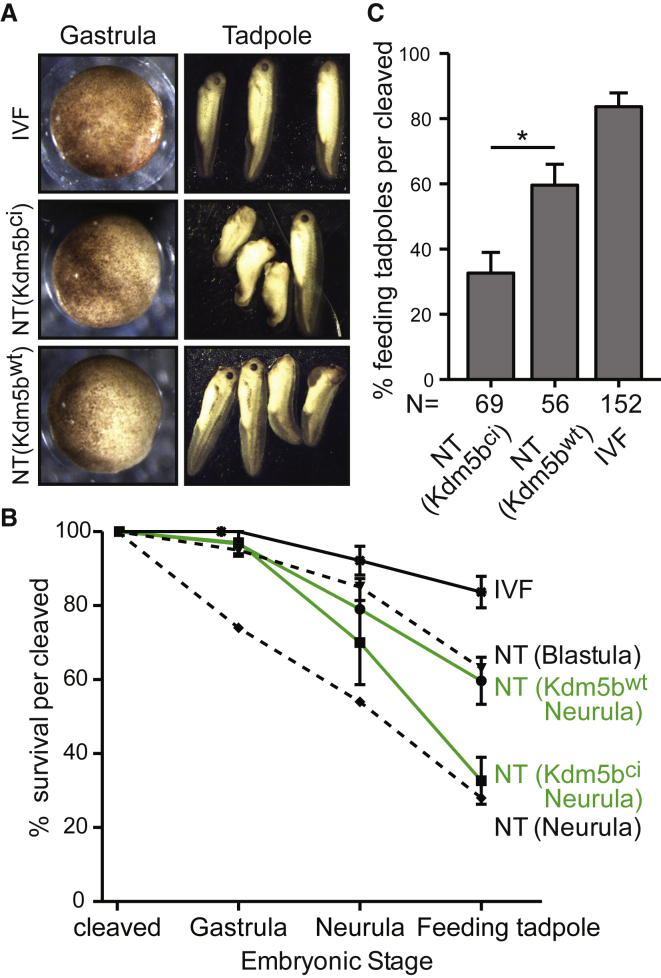
H3K4 Demethylation in Donor Nuclei Improves the Development of NT Embryos(A) IVF, NT(Kdm5bci), and NT(Kdm5bwt) embryos at the gastrula and tadpole stages.(B) The development of IVF, NT(Kdm5bci), and NT(Kdm5bci) gastrula embryos (stage 10.5) was followed until feeding tadpole stage (green lines and black solid line, respectively). Black dashed lines indicate the developmental potential of NT embryos generated from uninjected blastula stage or neurula stage endoderm nuclei (data from Gurdon, 1960). y axis is the percentage of gastrula embryos reaching the indicated stages.(C) Kdm5bWT expression in the donor cell improves the development of NT embryos to the feeding tadpole stage. Bar graph showing the percentage of cleaved gastrula embryos reaching the feeding tadpole stage (∗p value = 0.0007, paired t test, one-tailed). Data are presented as mean ± SEM.See also Figure S4 and Table S1.